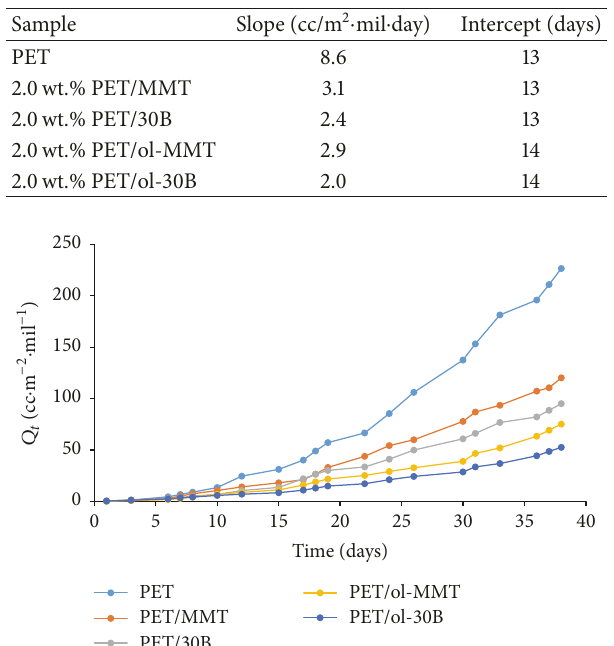
Figure 15: Cumulative permeability data for sidewall of stretched blown PET and nanocomposite